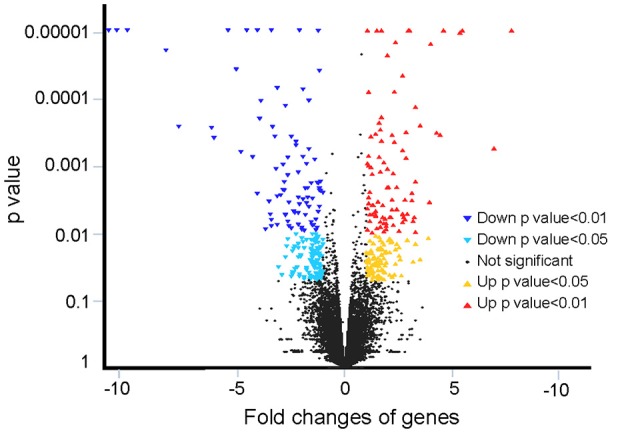
Overview of fold changes in gene expression in this study. The y-axis indicates the statistical p-value, and the x-axis indicates the fold changes of genes.